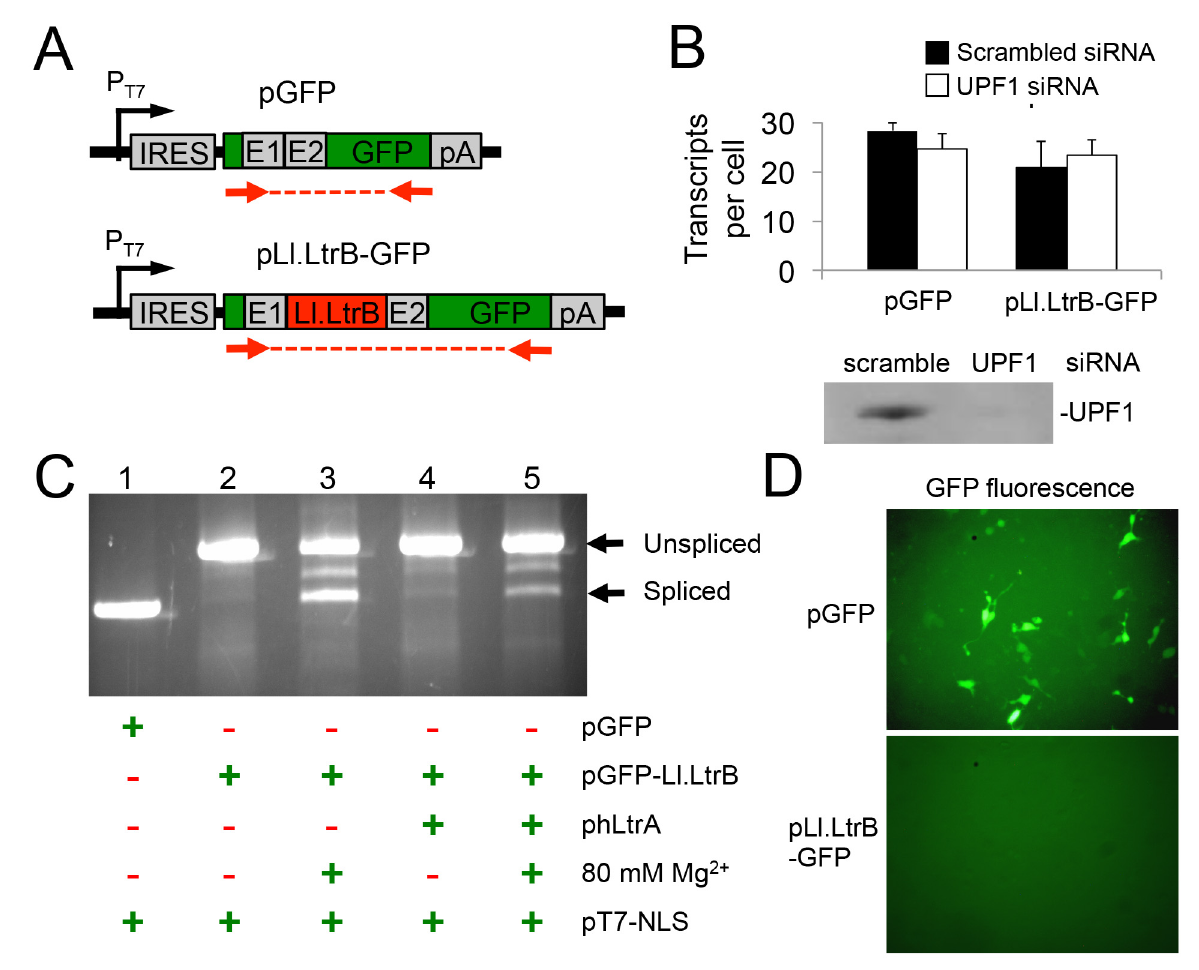
Fig 4. A T7 RNAP transcript containing the Ll.LtrB intron is not degraded by nonsense mediated decay in human cells and can be spliced after addition of Mg 2+ to the cell culture medium. (A) Diagram of pT7 transcription cassettes expressed from plasmids pLl.LtrB-GFP and pGFP, which contain either the Ll.LtrB intron and short flanking exons or just the ligated-exon sequences that would result from Ll.LtrB intron splicing inserted at the same location within the GFP ORF. Red arrows show the location of primers used for RT-PCR and RT-qPCR of Ll.LtrB intron splicing. (B) RNAi knockdown of UPF1. HEK- 293 cells were pretreated for 24 h with either scrambled siRNA (black) or UPF1 siRNA (white) to inhibit NMD and then transfected with the pGFP or pLl. LtrB-GFP. At 48 h after transfection of the plasmids, the number of GFP transcripts per cell was measured by RT-qPCR. The immunoblot below the bar graph confirms knockdown of UPF1 protein by the UPF1 siRNA but not by the control scrambled siRNA in HEK-293 cells at 72 h after transfection of the siRNA corresponding to the time at which GFP transcript levels were measured. Equal amounts of cellular proteins were loaded in each lane. (C) RT-PCR assay for RNA splicing of Ll.LtrB transcripts in HEK-293 cells at 24 h after transfection of the indicated plasmids with or without 80 mM Mg 2+ added to the culture medium. The RT-PCR products were analyzed in a 1% agarose gel, which was stained with ethidium bromide. The positions of the PCR products corresponding to unspliced and spliced pLl.LtrB-GFP RNAs are indicated to the right of the gel. Splicing of the Ll.LtrB intron in HEK-293 cells with 80 mM Mg 2+ added to the culture medium was confirmed by sequencing across the ligated-exon junction in the PCR product. The experiment was done twice with similar results. (D) GFP fluorescence in HEK-293 cells transfected with plasmids pGFP or pLl.LtrB-GFP + phLtrA with 80 mM MgCl 2 added to the culture medium. Images were taken 72 h post-transfection. The experiment was done twice with similar results. Abbreviations: E1 and E2, 5 ’ and 3 ’ ltrB exons, respectively; IRES: internal ribosome entry site; pA, polyadenylation signal; PT7: T7 RNAP promoter.